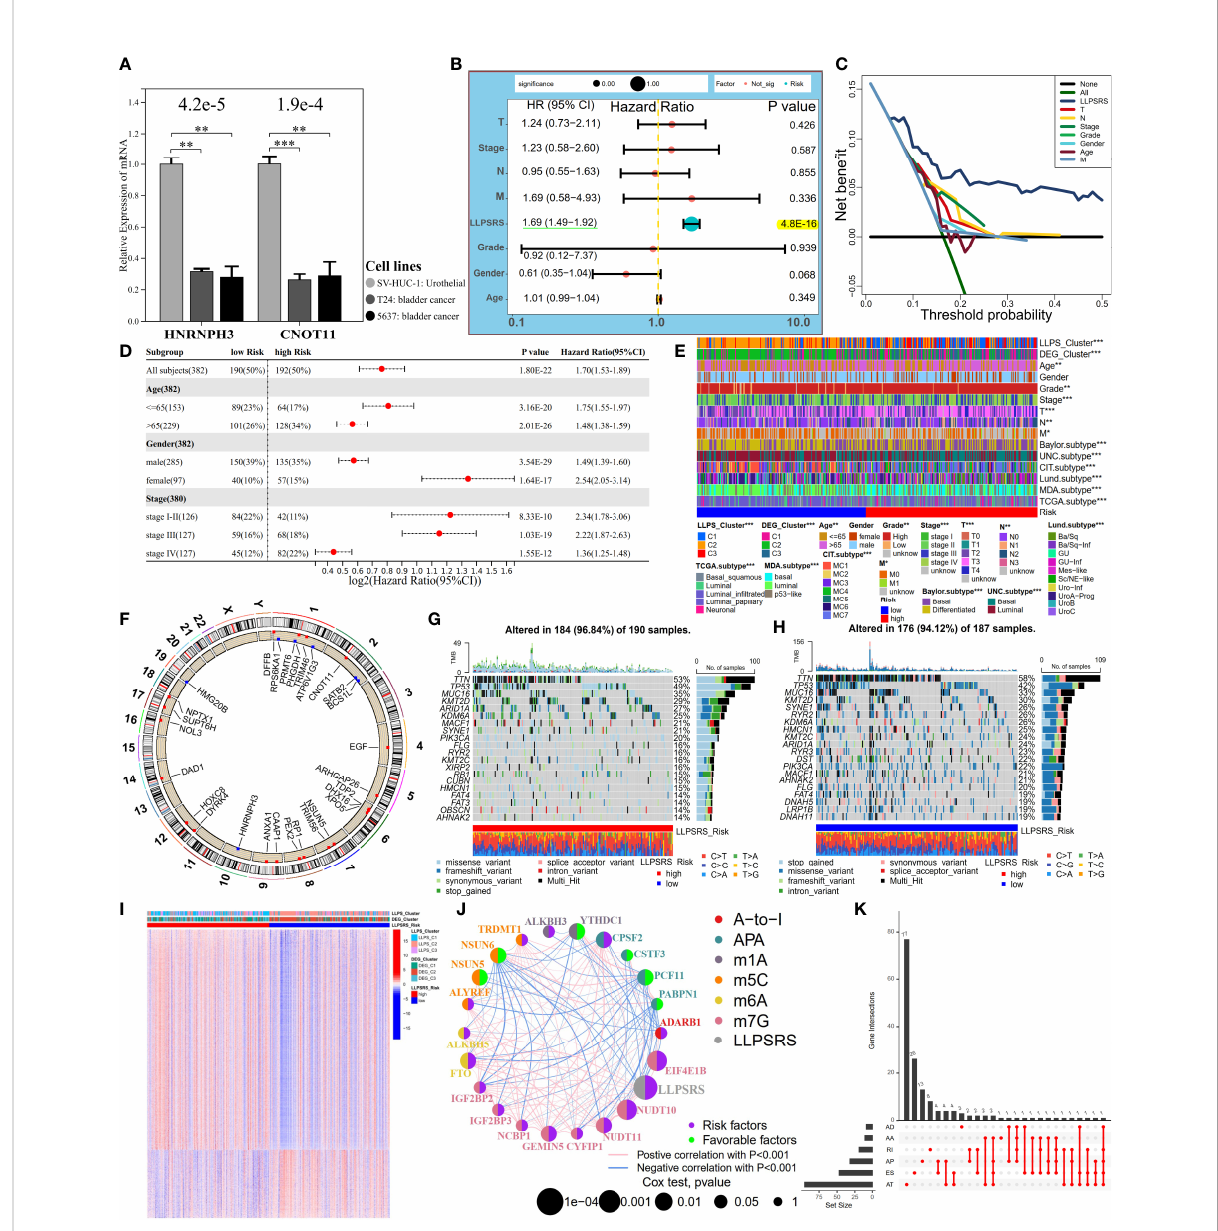
FIGURE 5 LLPSRS ’ s association with clinicopathological features, genomic variations, and epigenetic alternations. (A) Differential transcript levels of HNRNPH3 and CNOT11 in BLCA and normal urothelial cell lines. (B, C) Multivariate Cox analysis and DCA of LLPSRS and seven clinical traits in TCGA-BLCA cohort. (D) Univariate Cox analysis of LLPSRS with OS in several strati fi cations. (E) Differential clinical traits and molecular subtypes between the high- and low-risk subgroups (chi-square test). (F) Twenty-nine RSGs ’ location of CNV alterations on chromosomes. (G, H) Waterfall plots showing the mutation distribution of top 20 mutated genes in two subgroups. (I) Heatmap of DMCGs in two subgroups. (J) The interactive network and prognostic implications of LLPSRS and 21 RNA editing regulators. The left half-circle represents different RNA modi fi cation patterns, and the right half-circle represents whether these regulators were risk or protective factors for OS. The color of lines indicates correlations between abovementioned regulators, and the size of circles represents p-values for prognostic implications of these regulators. (K) Statistics on the counts and types of 161 DEGs with AS. The asterisks represent the p-value (*p< 0.05; **p< 0.01; ***p< 0.001). LLPSRS, liquid – liquid phase separation-related risk score; BLCA, bladder cancer; DCA, decision curve analysis; OS, overall survival; CNV, copy number variation; DMCGs, differentially methylated CpG islands; AS, alternative